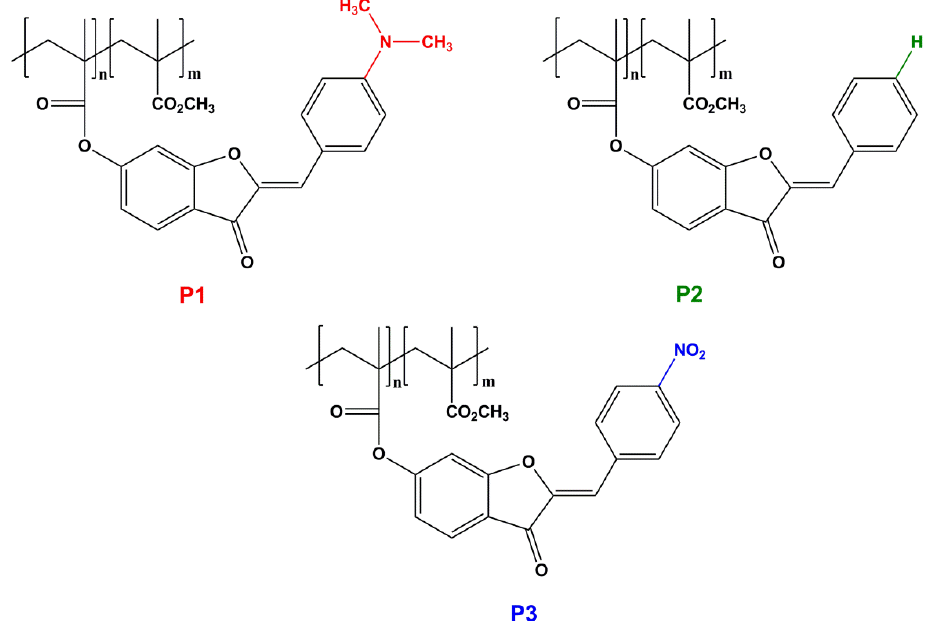
Figure 1. Aurone-based methacrylic polymers.